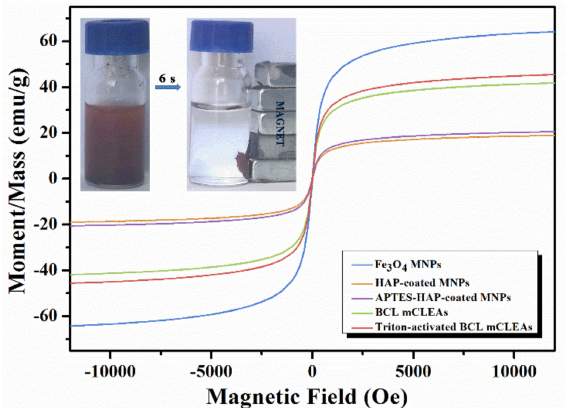
Figure 3. Hysteresis loops of Fe 3 O 4 MNPs, HAP-coated MNPs, APTES-HAP-coated MNPs, BCL mCLEAs and Triton-activated BCL mCLEAs. The inner shows the easy magnetic separation of Triton-activated BCL mCLEAs in reaction